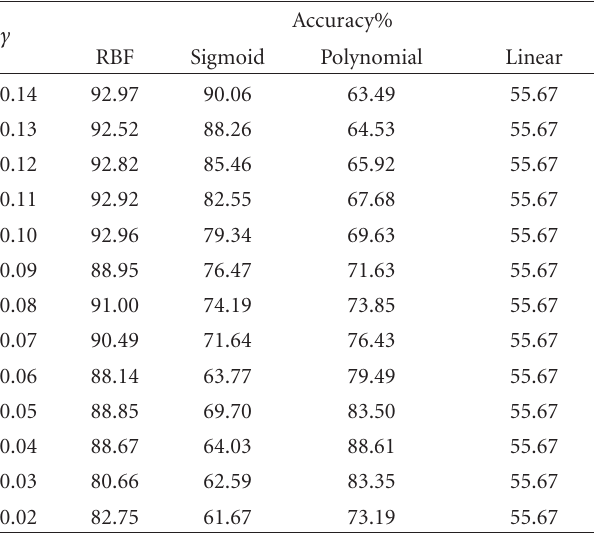
Table 3: Comparison between SVM kernels with varying γ in steps of 0.01 in each model. The table is obtained from four di ff erent images representing a total of approximately 4 × 10 6 pixels and four di ff erent SVM Kernels. The number of training data pixels was 3844. Accuracy% γ RBF Sigmoid Polynomial